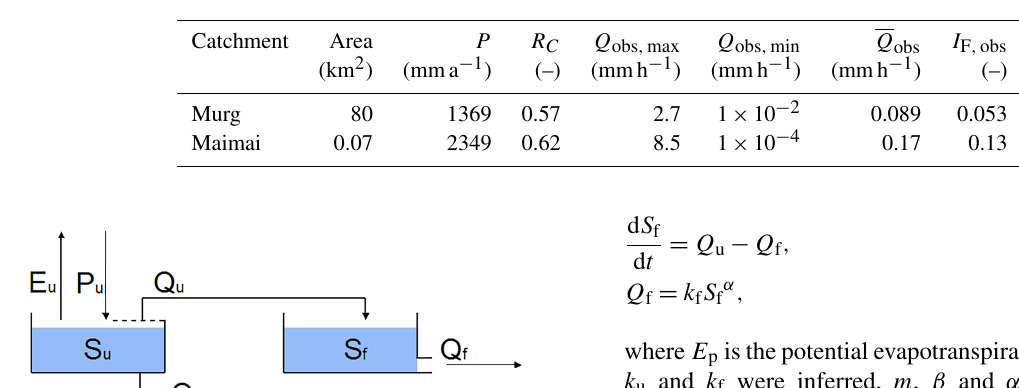
Table 2. Properties of the two case study catchments. P is the precipitation and R C the runoff coefficient (calculated from cumulative streamflow and precipitation). Q obs , max , Q obs , min and Q obs are the minimum, the maximum and the average streamflow, respectively. I F , obs is the flashiness index.